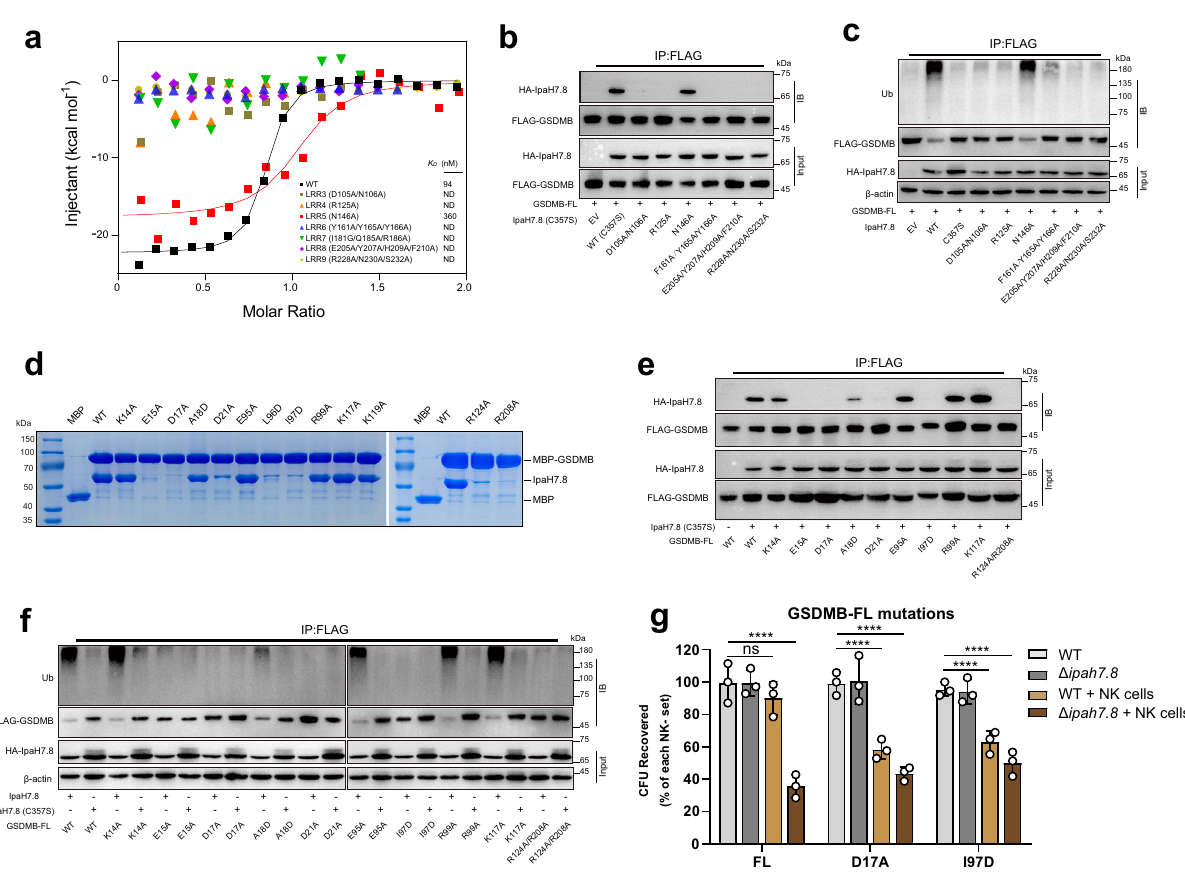
Fig. 5 | The GSDMB-IpaH7.8 interactions are essential for suppressing NTD- mediatedporeformation.a Quanti fi cationofthebindingaf fi nitybetweenGSDMB andIpaH7.8byITC. b ThemutationsonIpaH7.8impairthebindingofGSDMB.The protein complex was immunoprecipitated with anti-FLAG antibody, and analyzed by western blotting with the indicated antibodies. c Ubiquitination assay for GSDMBbyIpaH7.8. Mutations onIpaH7.8 failedto ef fi cientlyubiquitinate GSDMB. Ub,anti-ubiquitinantibodies. d Invitropull-downofIpaH7.8byMBP-taggedWTor mutant GSDMB proteins. e The co-immunoprecipitation assay of IpaH7.8 with WT or mutant GSDMB proteins. f Disruption of the GSDMB-IpaH7.8 interactions